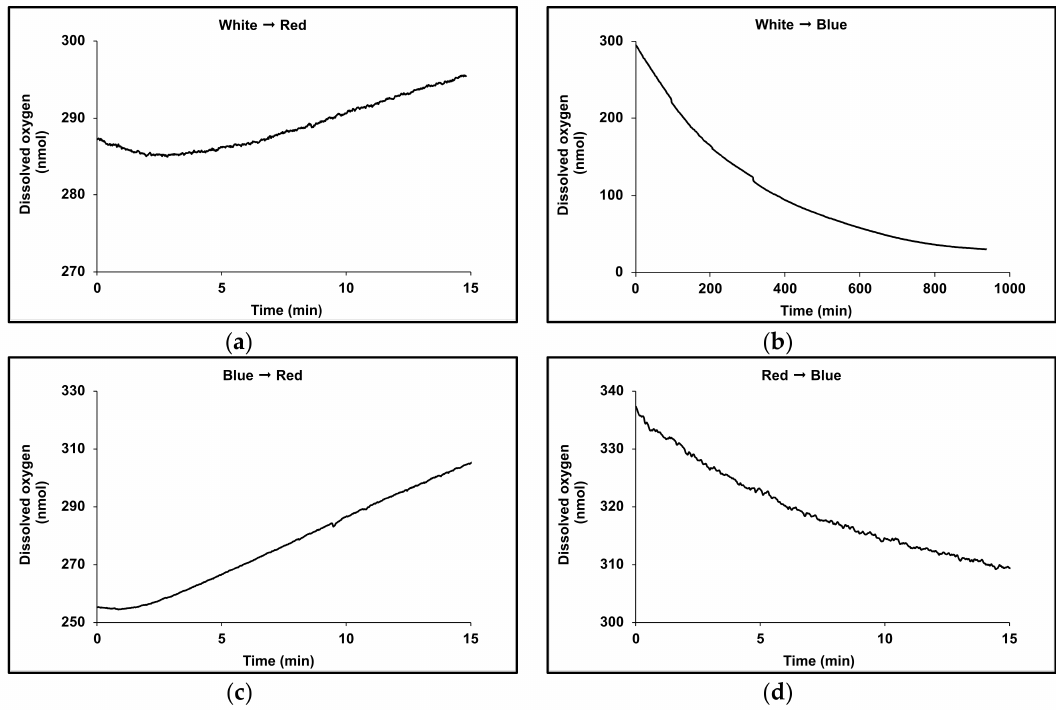
Figure 8. Rate profiles for oxygen uptake / evolution measured with di ff erent wavelengths of LED lights measured using a Clark-type electrode for 1.5 mL cultures of D. salina CCAP19 / 41 maintained at 25 °C. ( a ) Red light acclimated cultures measured under blue light. ( b ) Blue light acclimated cultures measured under red light; ( c ) White light acclimated cultures measured under red light; ( d ) White light acclimated cultures measured under blue